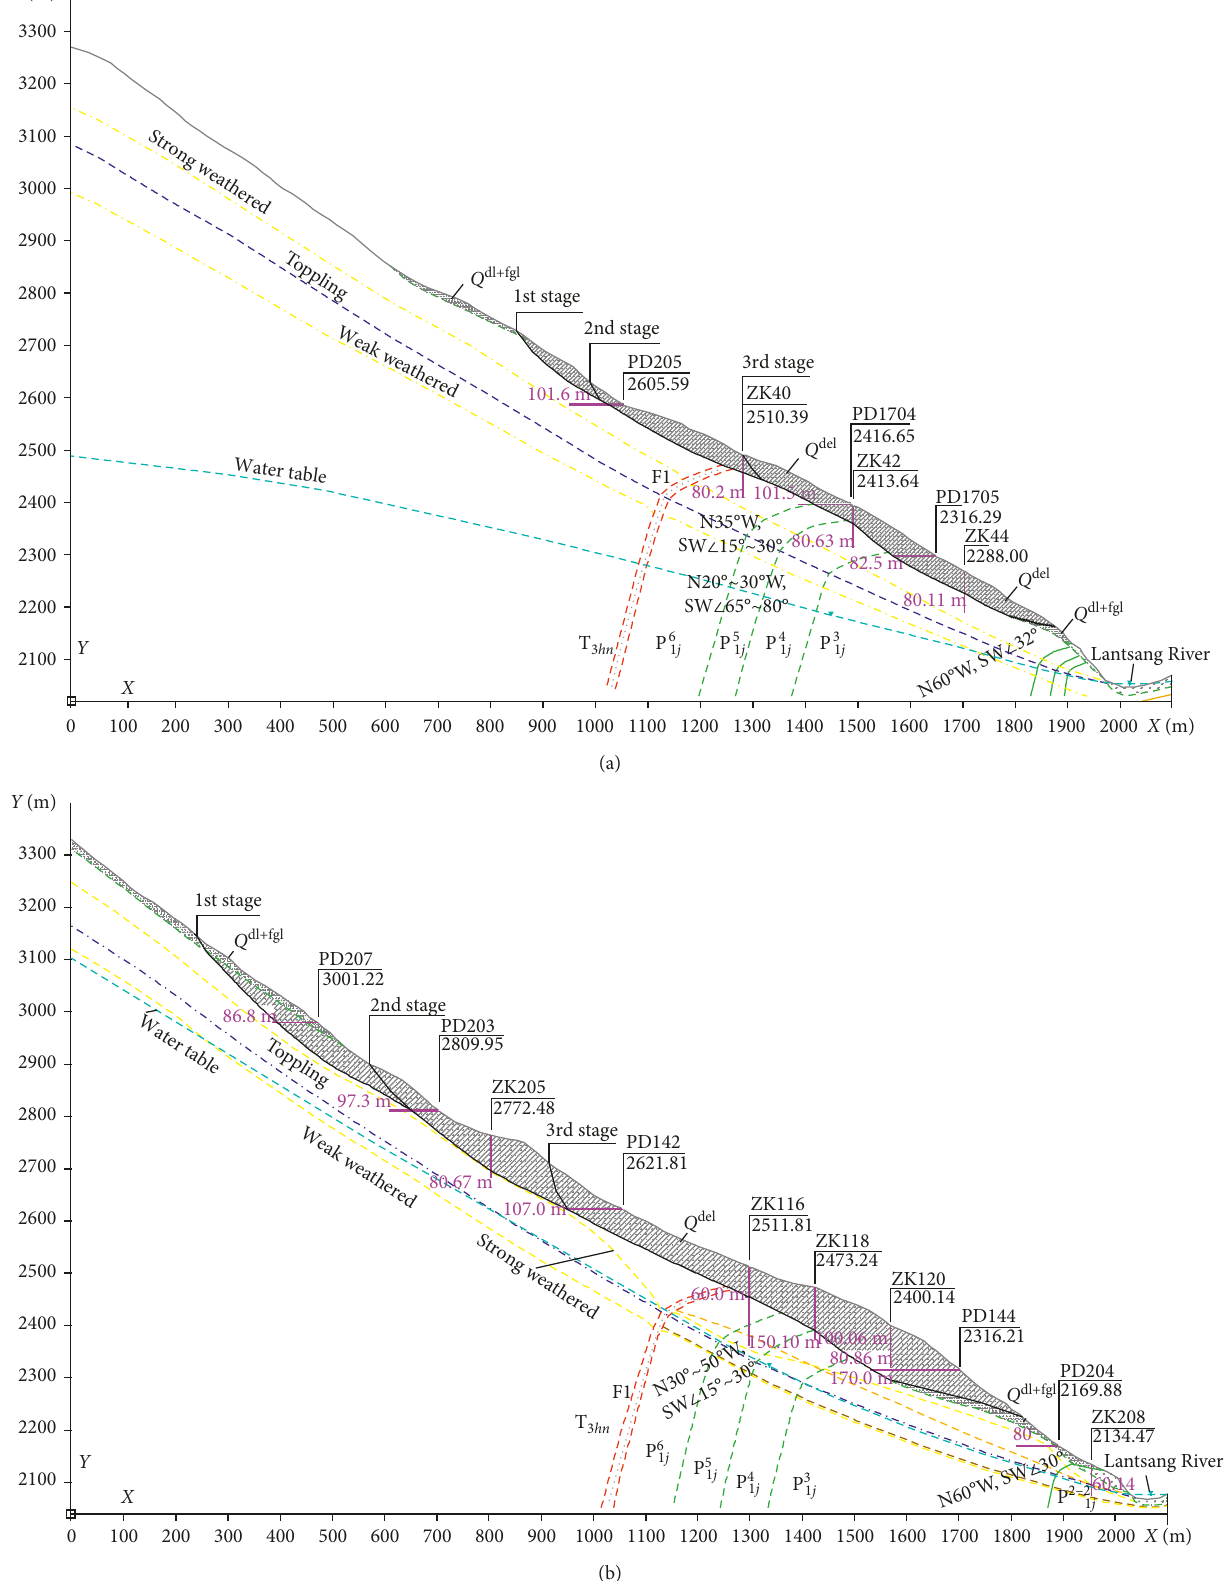
Figure 5: Typical profiles of the Zhenggang landslide: (a) A-A